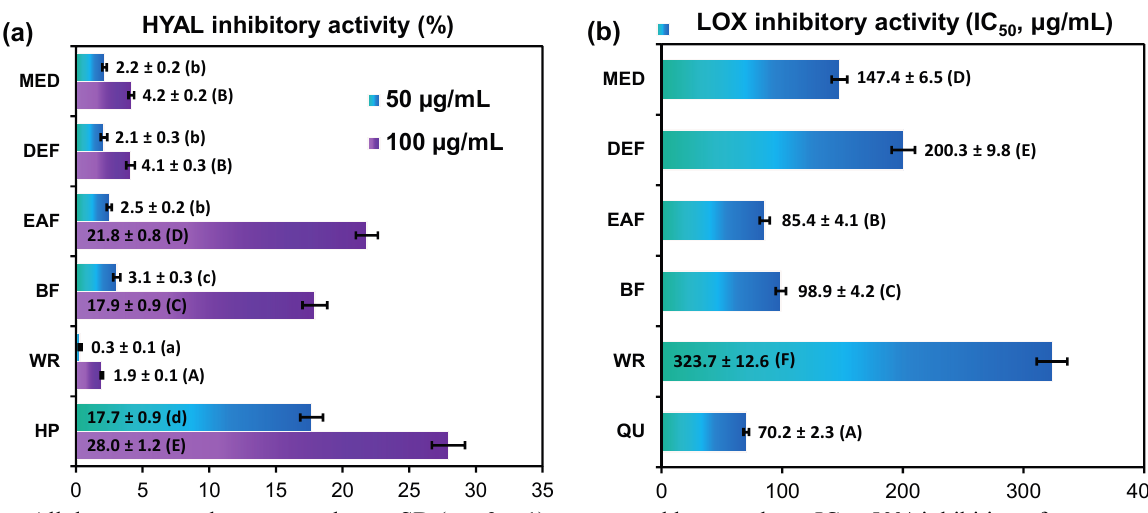
Figure 3. Anti-inflammatory activity of G. procumbens dry leaf extracts: inhibitory activity on: ( a ) hyaluronidase and ( b ) lipoxygenase.